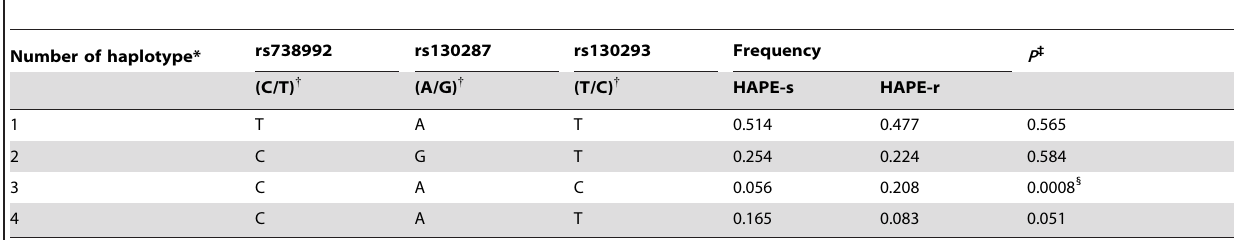
Table 4. The frequencies of the most four common haplotypes from rs738992, rs130287, and rs130293 SNPs in HAPE-s and HAPE-r